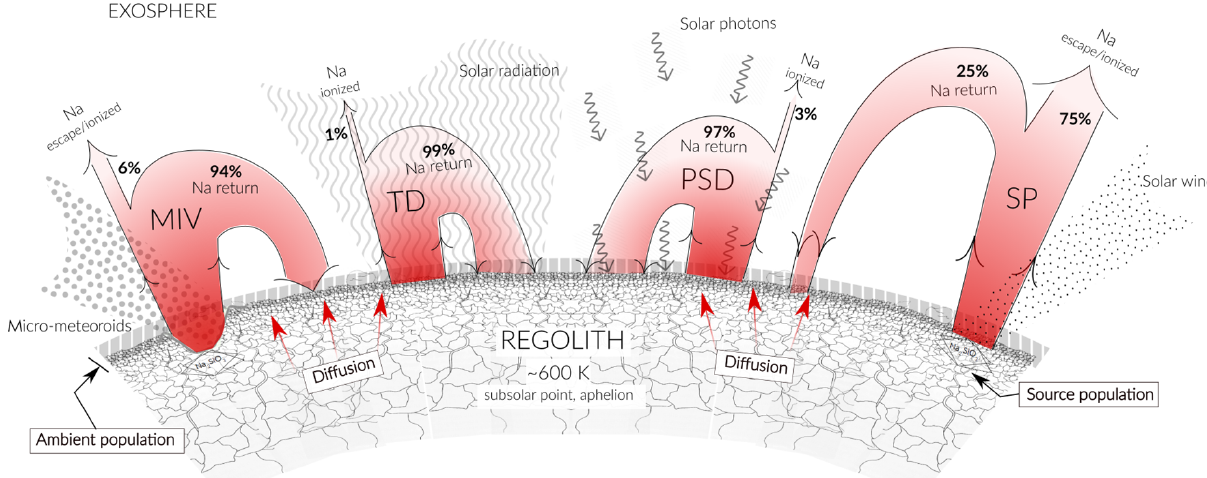
Figure 5. Scheme illustrating the different released fluxes of Na due to the different release mechanisms from the mineral compound (the source population) and from surface (the ambient population). The illustration is not to